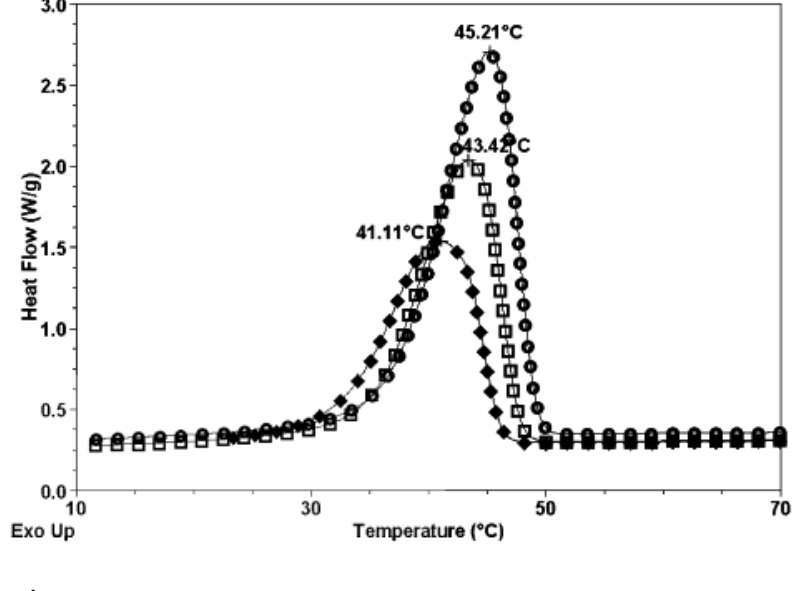
Figure 10. DSC thermograms showing the non-isothermal crystallization at 10 °C min −1 for PEO based composites filled with 0 (  ), 10 (  ), and 30 wt% (  ) of tunicin whiskers